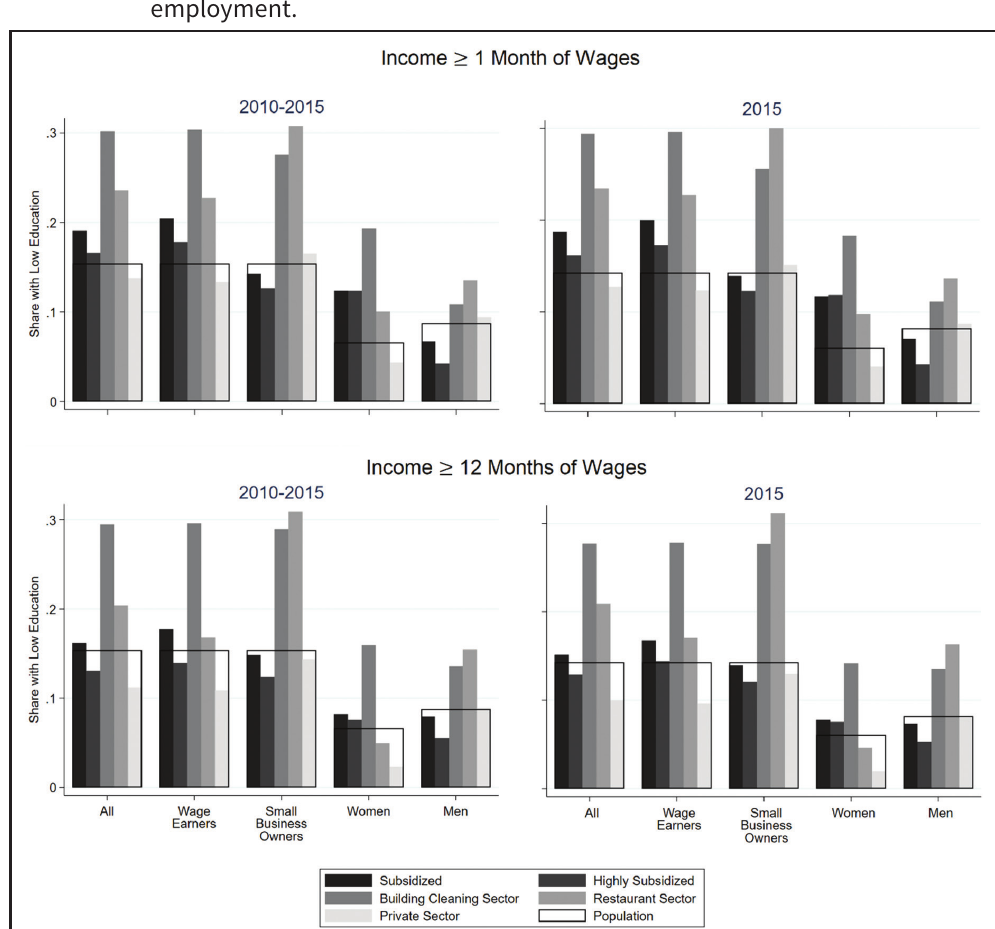
Figure W8 Share with low education for two alternative income thresholds for